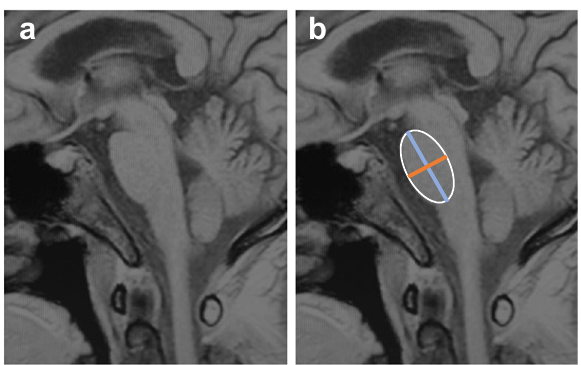
Fig. 5 Schematic diagram of the measurement of the anteropos- terior diameter of the pons. a T1-weighted image on conventional midsagittal MRI. b Regions of interest were placed over the pons and the midbrain in the midsagittal slice. Two vertical lines were drawn. Blue line de fi ned the superior-inferior axes. Orange line represented the anteroposterior